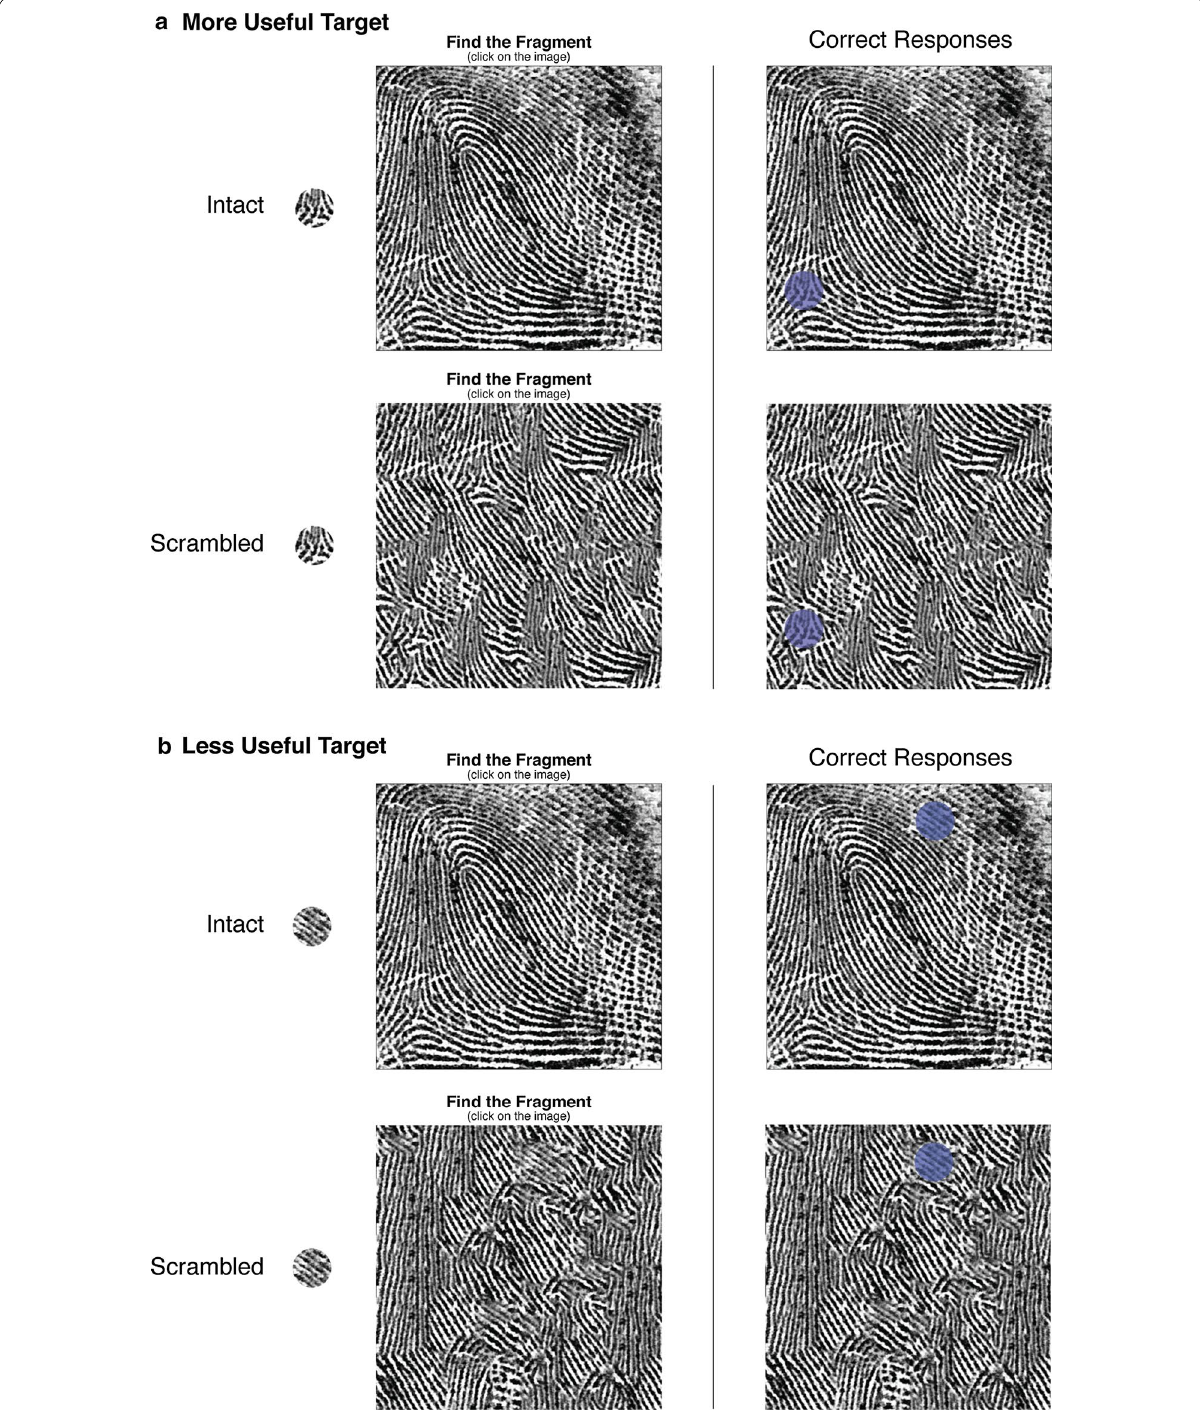
Fig. 1 A schematic diagram of the Find-the-Fragment task used in Experiment 1. On the left, we provide an example of each of the trial types: the array fingerprint was either an intact fingerprint or scrambled, and the target feature was either a ‘more useful’ feature ( a ), or ‘less useful’ feature ( b ). When generating the scrambled fingerprints, we kept the location and appearance of the fragments identical to those in the intact prints. The correct locations of the fragments for each example are displayed on the